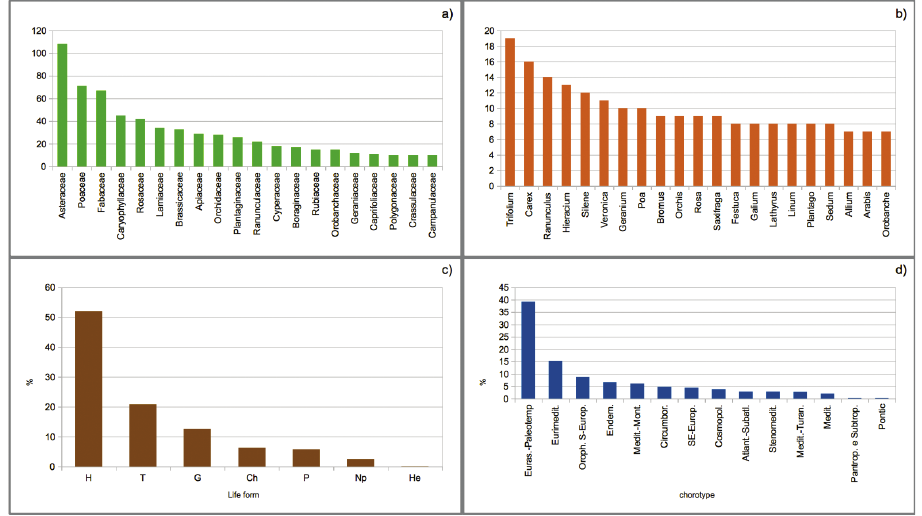
Figure 2. a number of taxa per family; only the families with more than 10 taxa are shown b number of taxa per genus; genera containing more than 7 taxa are shown c life form percentages d chorological spectrum of the detected flora in the study